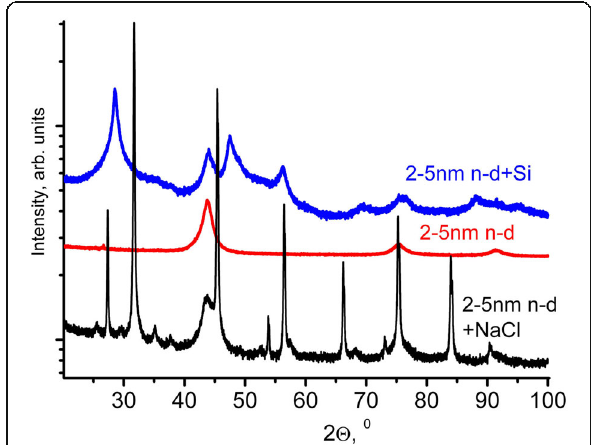
Fig. 1 The X-ray powder diffraction (XRD) spectra of initial 2 – 5-nm nanodiamond (2 – 5 n-d) and 2 – 5-nm nanodiamond treated in a planetary mill with a mixture of 25 wt% of Si (2 – 5 n-d + Si) and NaCl (2 – 5 n-d +